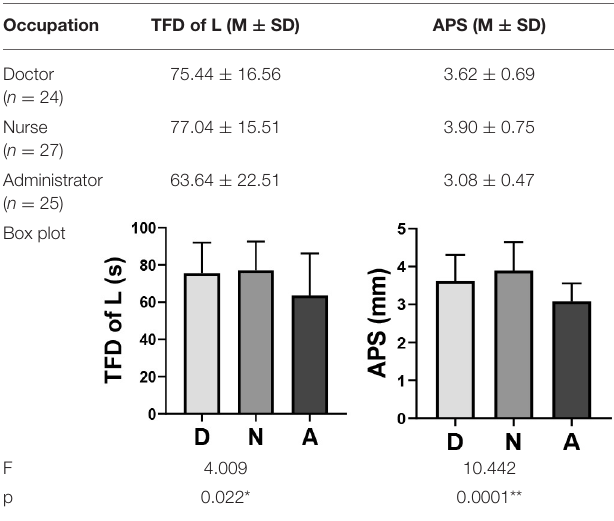
TABLE 4 | One-way ANOVA of EMM between three